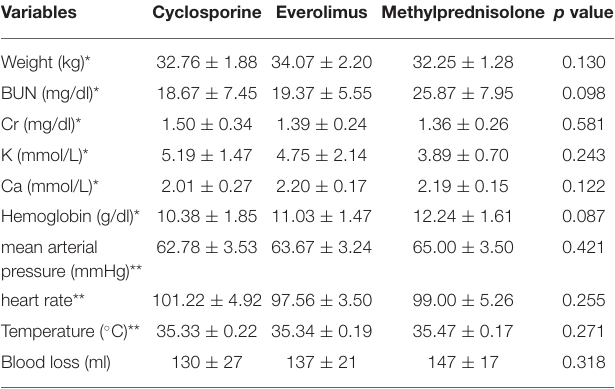
TABLE 1 | Baseline data.